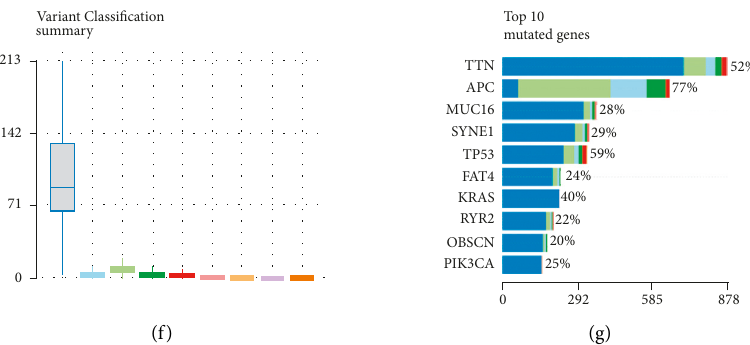
Figure 1: Landscape of somatic mutations of CRC. (a) Oncoplot and waterfall plot showing the somatic landscape of top 31 mutated genes in CRC. The distribution of variant classification (b), variant type (c), and SNV class (d) present. (e)-(f) Mutation load of each sample (variant classification type), and stacked bar graph shows the top ten mutated genes, including TTN, APC, MUC16, SYNE1, TP53, FAT4, KARS. RYR2, OBSCN, and PIK3CA.